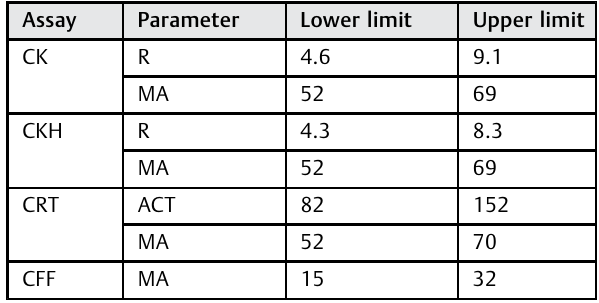
Table 1 Reference ranges for TEG 6s assay parameters